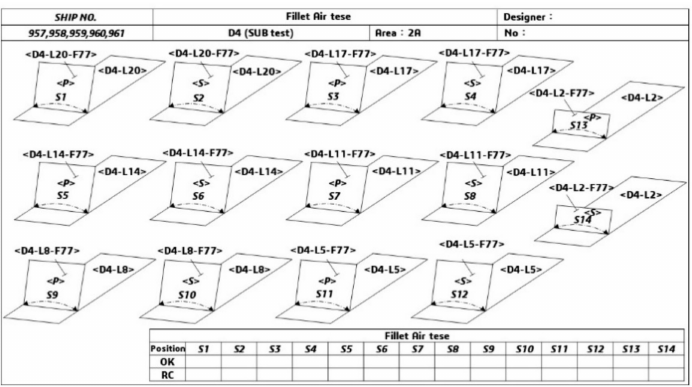
Figure 10. Group pressure test